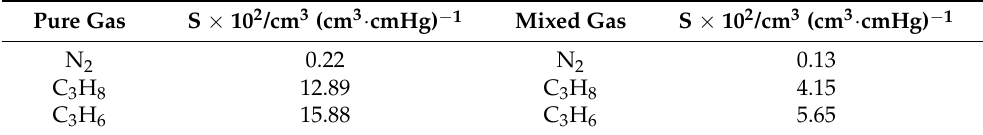
Table 4. Solubility coefficients for the three gases as pure gases and as mixed gases in PDMS at 298